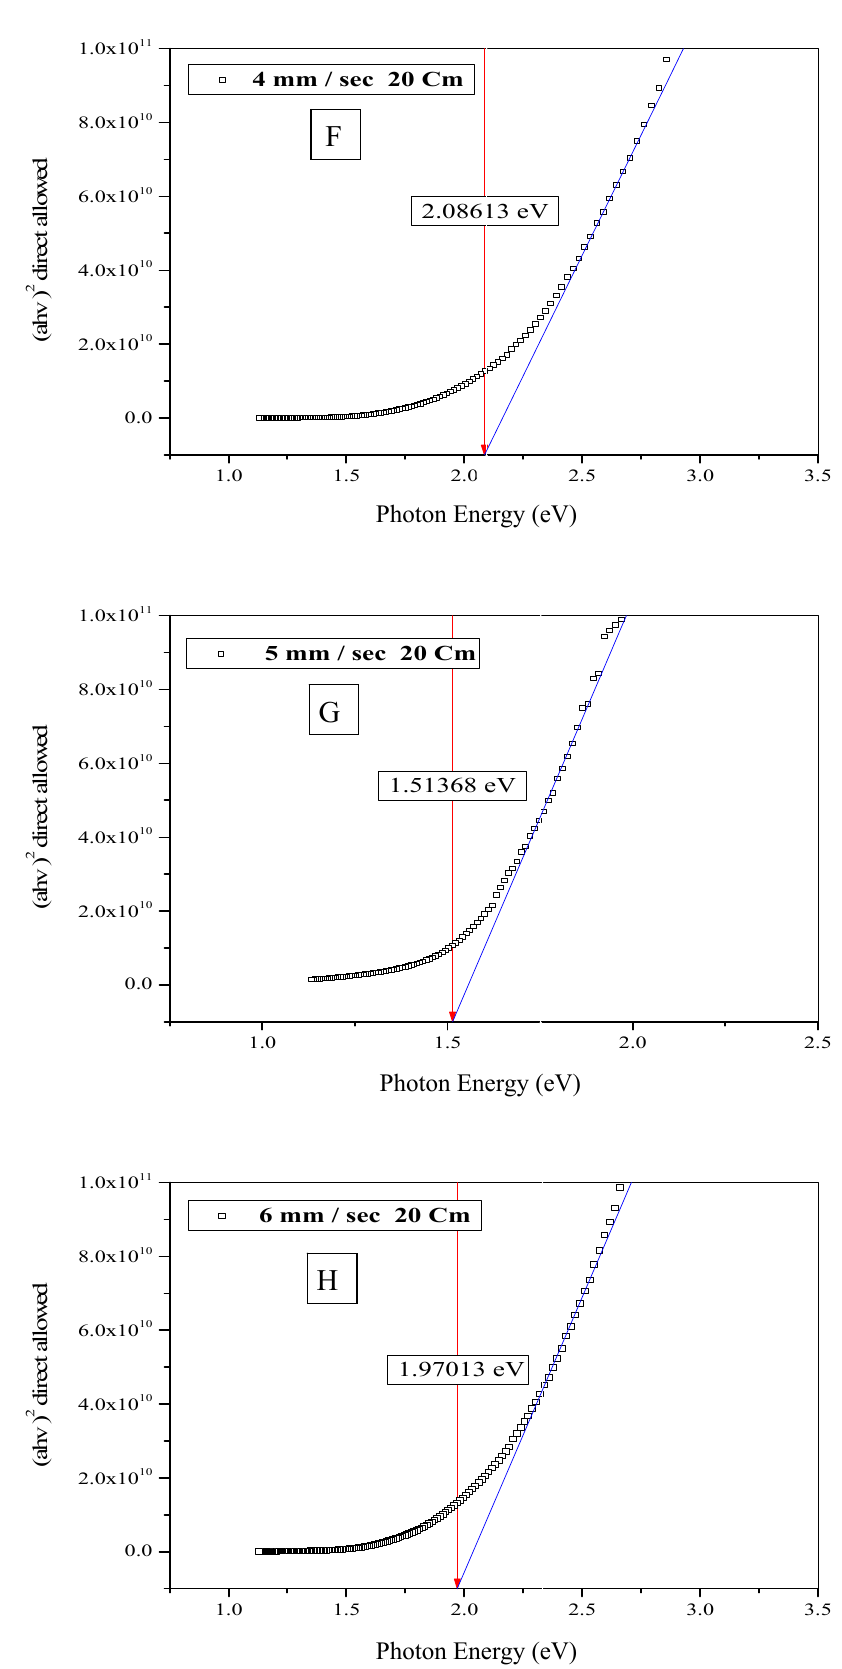
Fig. 5(F, G, H): Energy band gap of CuO at different preparations